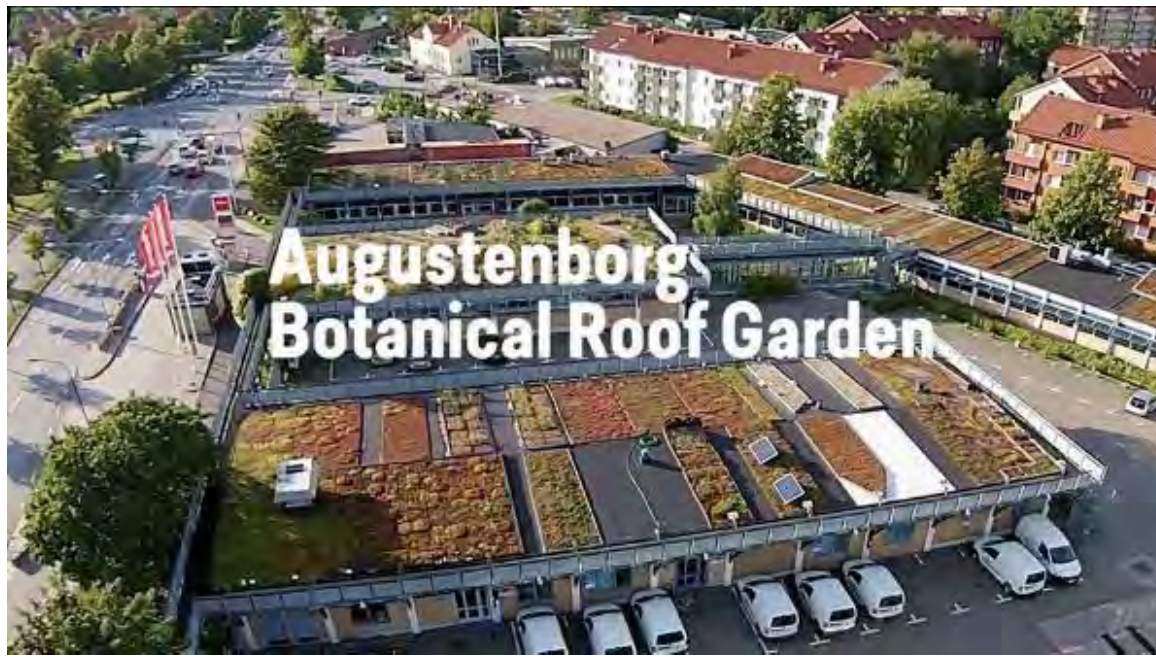
Fig.21: Roof Gardens. (Klamméus,